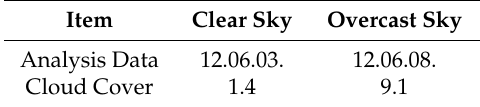
Table 7. Cloud cover of the analysis data for PCS standby loss analysis.